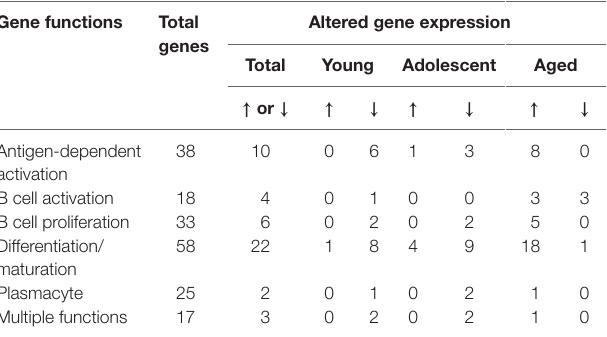
TaBle 2 | alterations in gene expression in healthy gingival tissues related to gene functional categories. gene